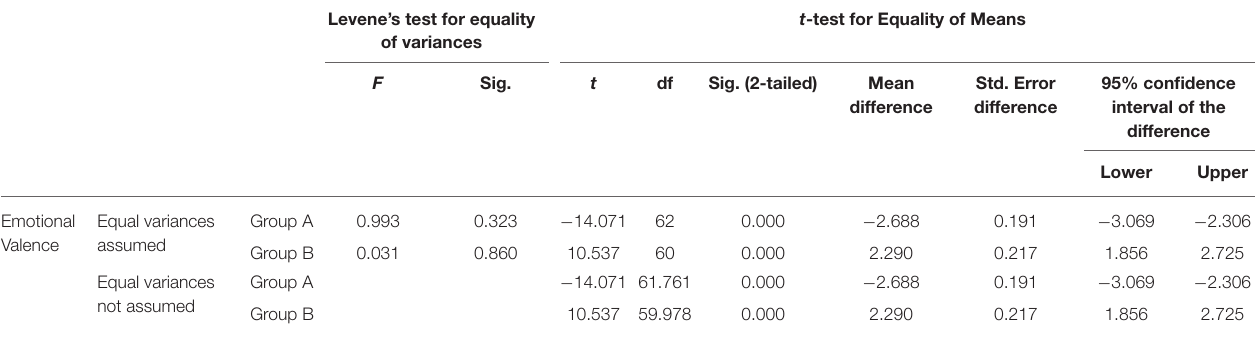
TABLE 2B | Comparison of emotional valence before and after the inducement.